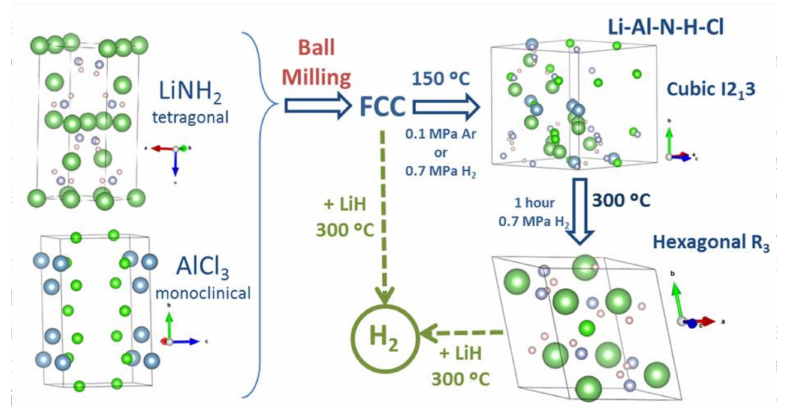
Figure 2. The mechanical treatment of the LiNH 2 -AlCI 3 mixture lead to the formation of a FCC solid solution which, when thermally treated at 150 ◦ C, forms an amide-chloride phase isostructural with a cubic habit (SG I2 1 3). This phase transforms, under H 2 pressure, into the trigonal phase (SG R3) after heating at 300 ◦ C. The addition of LiH to the trigonal phase and FCC solid solution allows to achieve a full and reversible desorption at 300 ◦ C [35].